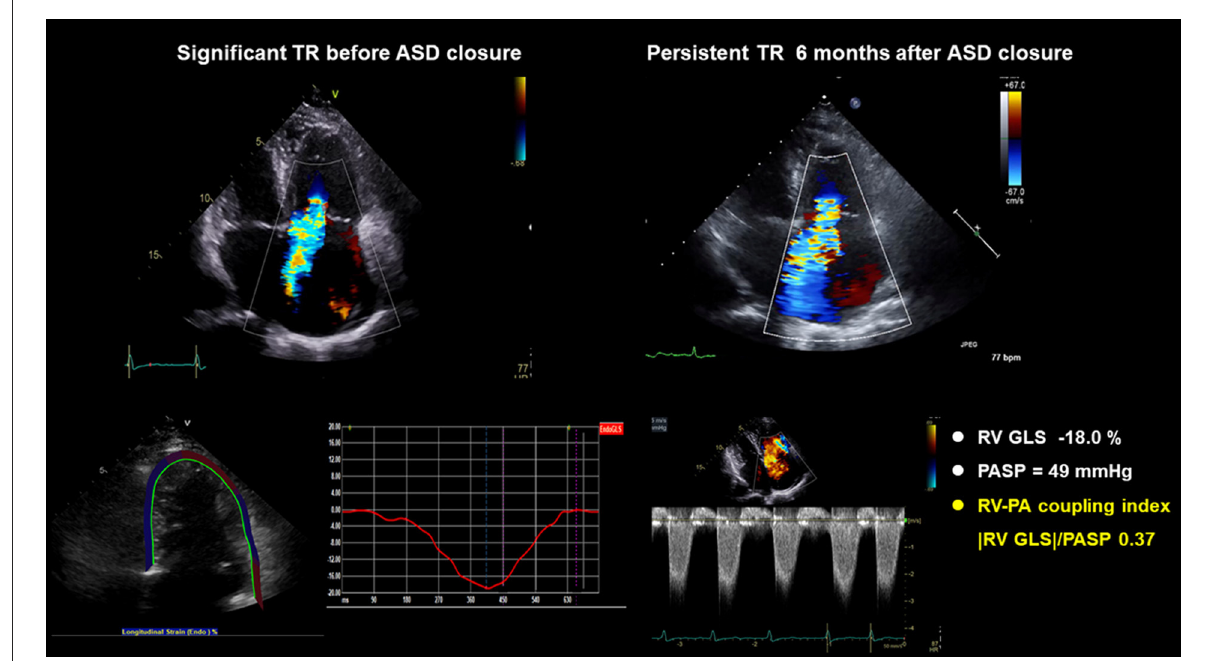
FIGURE4 A representative case: A 72-year-old woman with hypertension, diabetes, atrial fibrillation, and |RV GLS|/PASP ratio before ASD closure < 0.46, had persistent TR after ASD closure. ASD, atrial septal defect; RV GLS, right ventricle global longitudinal strain; PASP, pulmonary arterial systolic pressure; TR, tricuspid